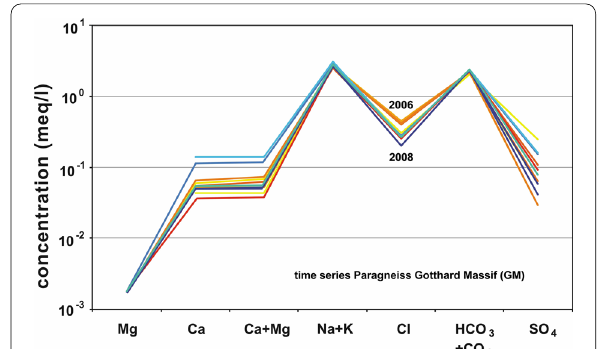
Fig. 13 Major dissolved components of water inflow (meq L − 1 ) at observation point 23.676 (Paragneiss of the Gotthard-Massif) for different sampling dates (Schöller Diagram): Yellow–red data from 2006 and 2007, blue from 2008 and 2009. Mg below detection limit 0.02 mg L − 1 (log meq L − 1 = = −